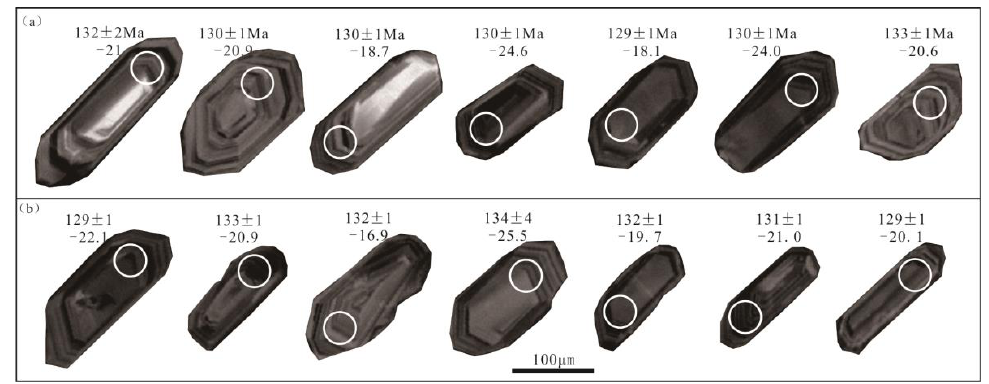
Figure 5. Zircon cathodoluminescence (CL) images of Leimengou granite porphyry ( a ) and monzonitic granite porphyry ( b ) with U–Pb ages and ε Hf (t).